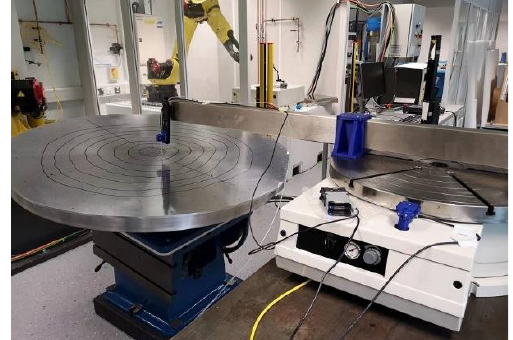
Fig. 2. SAP measuring a full-size